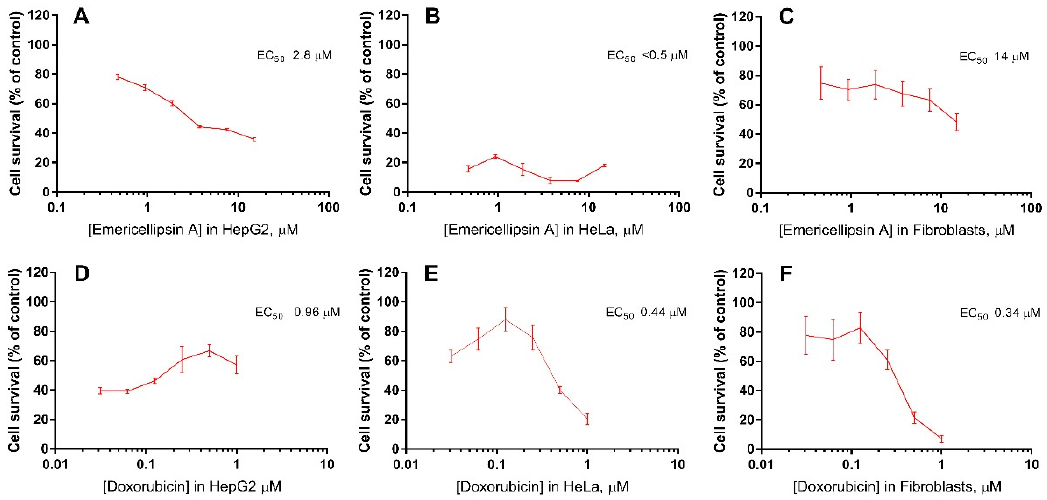
Figure 4. Comparative cytotoxic activity of emericellipsin A ( A – C ) and doxorubicin (positive control) ( D – F ): HepG2 tumor cell line ( A , D ); HeLa tumor cell line ( B , E ) and human fibroblasts ( C , F ).